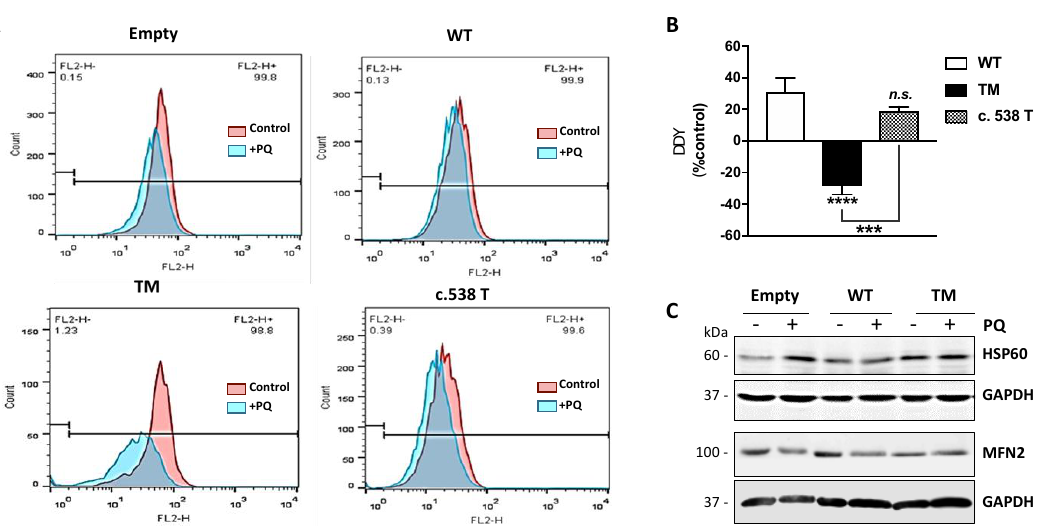
Figure 5. U87 cells transfected with triple mutant succinate semialdehyde dehydrogenase (TM SSADH) undergo mitochondrial damage upon paraquat (PQ) treatment. Cells were transfected for 24 h and then treated with 1 mM PQ for further 24 h. ( A ) Mitochondrial membrane potential ( ∆Ψ ) was measured by cytofluorimetric analysis using Mitotracker Red staining. Representative profiles are reported from one representative experiment out of three. Fluorescence intensity of the probe was monitored as FL2-H (x axis, 599 nm) versus cell counts (y axis). Ten thousand cells were analyzed for each sample; ( B ) ∆Ψ was normalized for mitochondrial mass (assessed by Mitotracker Green staining) and changes in ∆Ψ ( ∆∆Ψ ) after PQ treatment were represented as percentage with respect to cells transfected with the empty vector. Data are reported as mean ± SD. n = 3, *** p < 0.001, **** p < 0.0001. ( C ) Representative immunoblots of HSP60 and MFN2 protein levels. GAPDH was used as loading control. A total of 20 µg of total proteins was loaded on each lane.